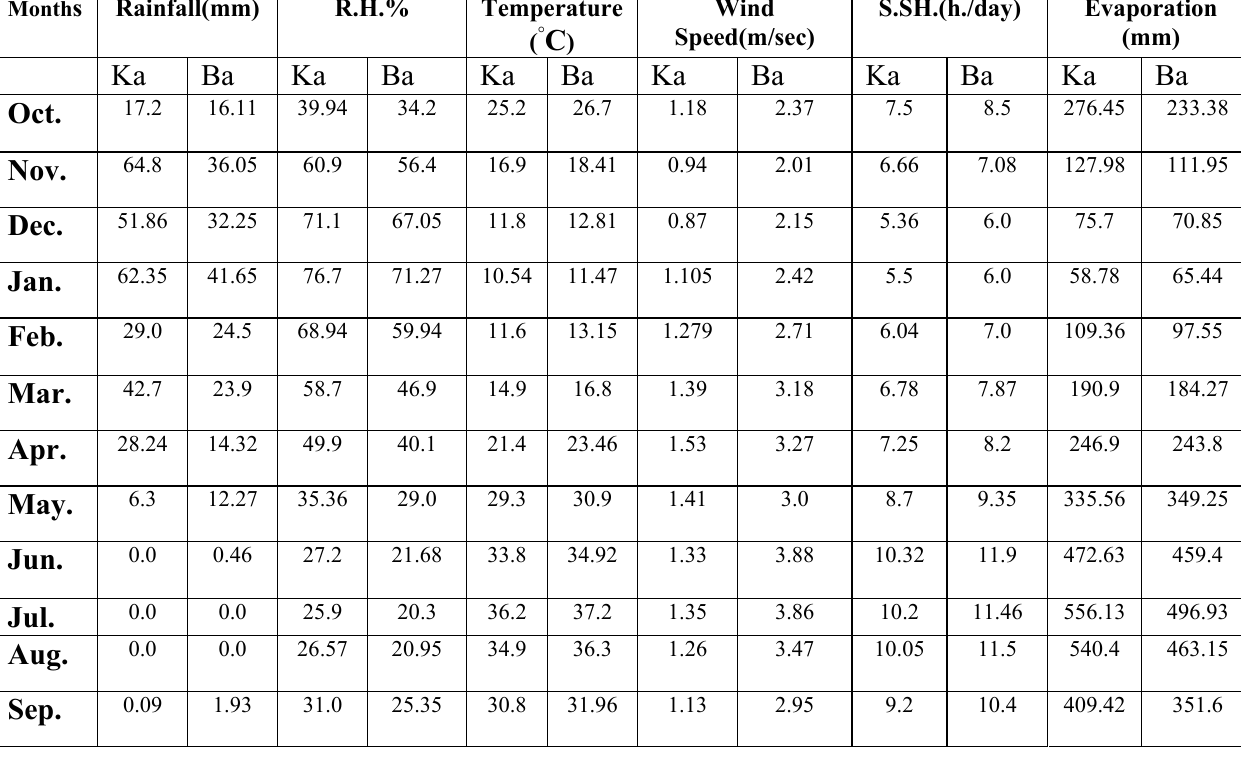
Table 1: Monthly averages for the various stations of Khanaqin climatic elements (Ka) and Badra (Ba) for the period from (1990 – 2013) [3]. Month s Rainfall(mm) R.H.%